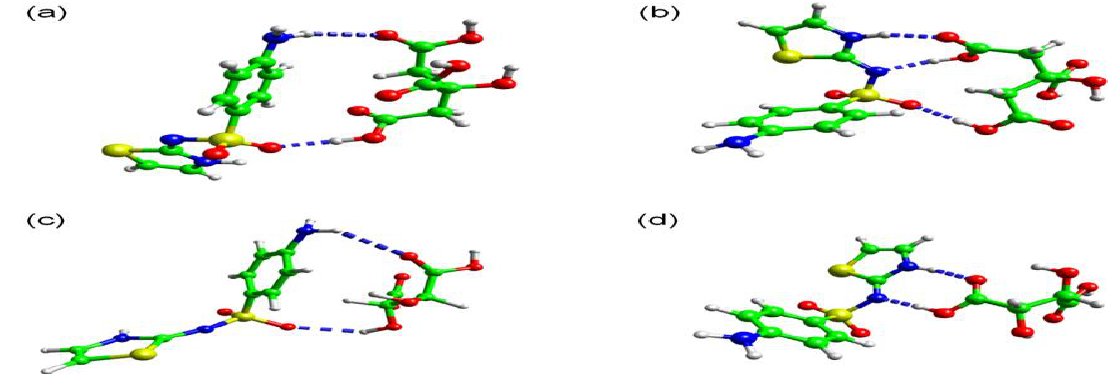
Figure 1. Calculated adduct structures for STZ−CA (a) and (b) and STZ−TA (c) and (d) (43) . Flory–Huggins interaction parameter (ᵡ) has been used to indicate the miscibility between small molecules in binary mixtures and estimate their phase stability. It has been reported that miscible